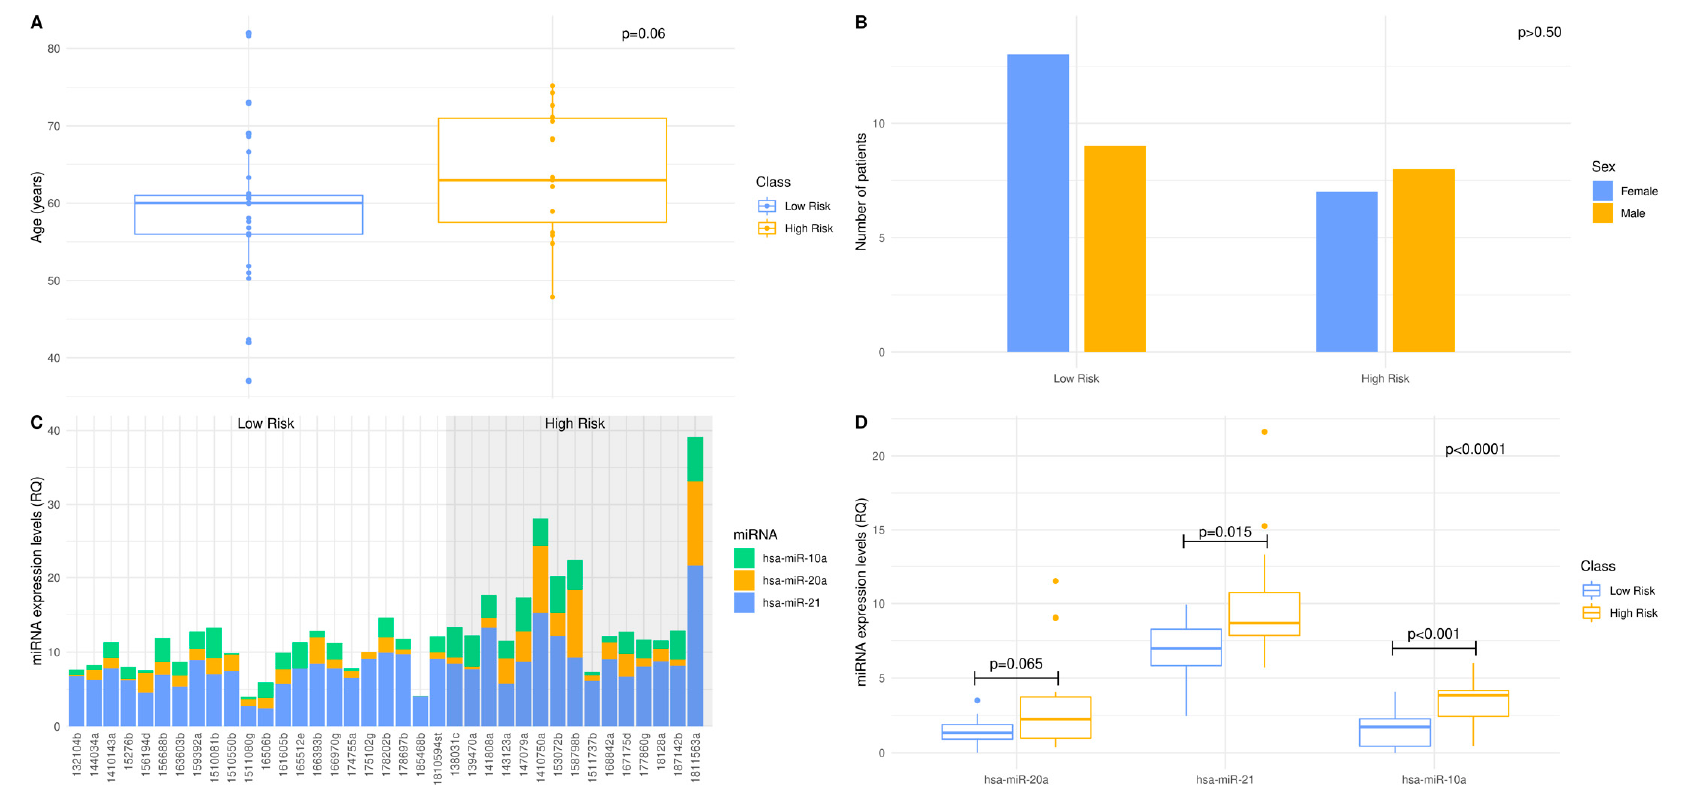
Figure 2. A 3-miRNA signature enables standard-of-care treated patients’ stratification to lower (OS > 12 months) vs. higher (OS < 12 months) risk groups: ( A , B ) Distribution of age and sex in low- and high-risk patients of the age- and sex-matched GBM cohort. The 12 months overall survival was used as threshold, to classify the GBM patients into low- and high-risk groups. Statistical analysis was performed by Wilcoxon signed-rank test. There was no statistical significance between low- and high-risk groups regarding age and sex as indicated by p -value = 0.06 and p -value > 0.50, respectively; ( C ) MiRNAs, hsa-miR-21, hsa-miR-20a and hsa-miR-10a, expression levels in each individual of the standard-of-care treated GBM cohort, as measured by qRT-PCR. The expression of each miRNA was normalized to the endogenous control, SNORD96A. Data are expressed as ∆ Cq values. The shaded area includes the high-risk group; ( D ) Box and whisker plot for the expression of hsa-miR-21, hsa-miR-20a and hsa-miR-10a in the low- and high-risk group of the standard-of-care treated GBM cohort. The dependence of each miRNA when the patients of the low-risk group are compared to those of the high-risk group, was examined by Wilcoxon signed-rank test. The 3-miRNA signature dependence, when the patients of the low-risk group are compared to those of the high-risk group, was examined by two-way factorial ANOVA for independent